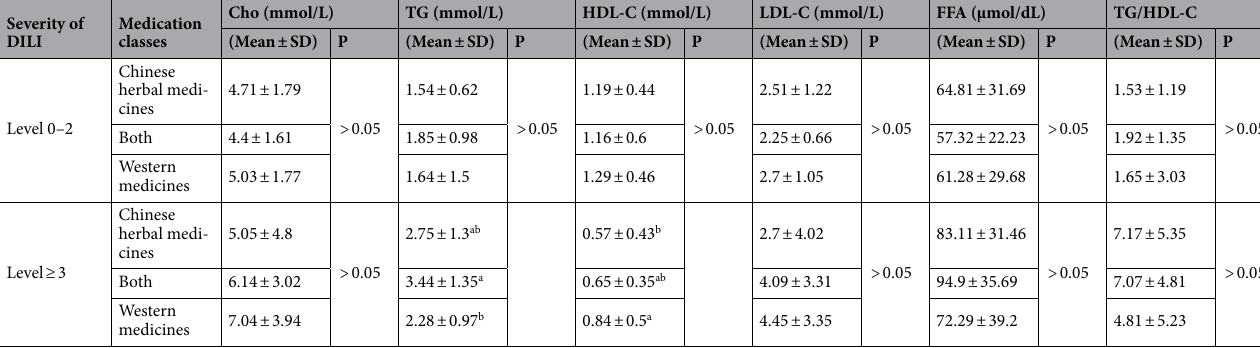
Table 6. Dyslipidemia and TG/HDL-C ratio of differnet medication classes in mild and severe DILI. TG triglyceride, Cho cholesterol, LDL-C low-density lipoprotein cholesterol, HDL-C high-density lipoprotein cholesterol, FFA free fatty acid, DILI drug induced liver injury. abc: significant difference (P ≤ 0.05) was shown.